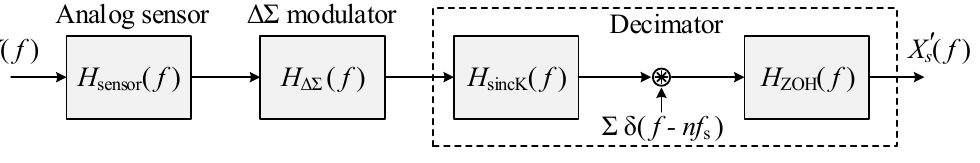
Figure 3. Structure of the measurement